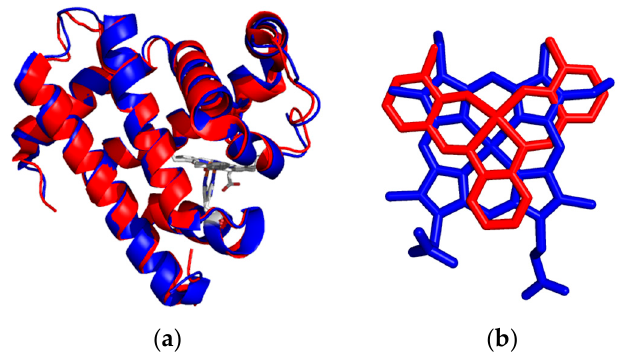
Figure 7. Overlay of the X-ray crystal structures of metmyoglobin (blue) and iron salophen substituted apoA71Gmyoglobin (red) ( a ); Active site comparison of the heme and iron salophen cofactors ( b ).